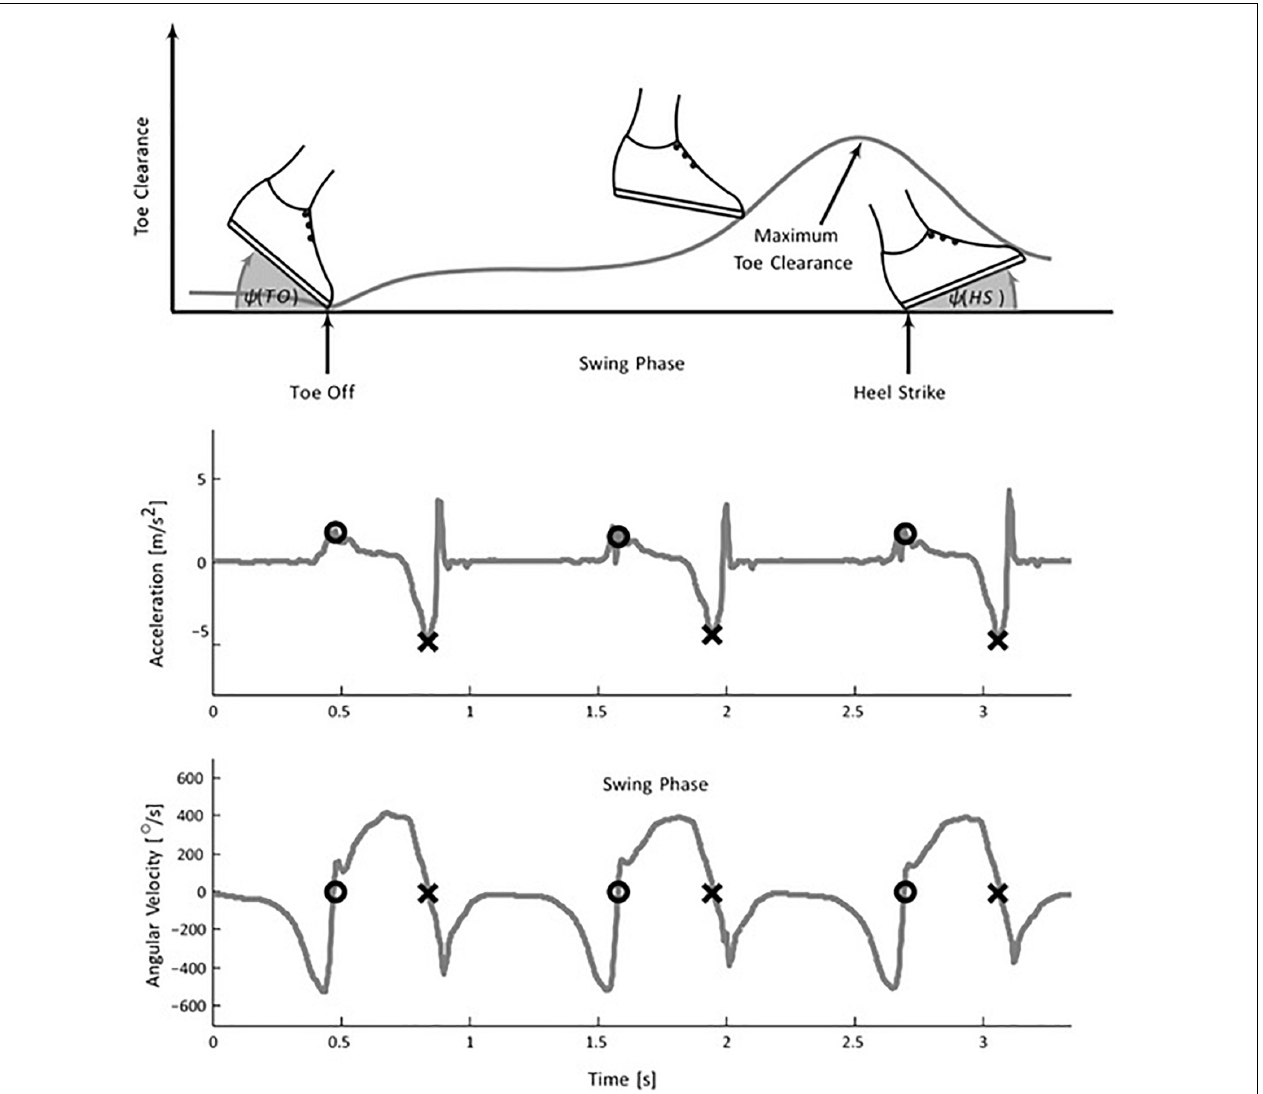
FIGURE 2 | Foot mounted inertial gait pattern in the sagittal plane. (Top) the plot shows a variation of foot angle (w.r.t. ground) at TO, HS, and toes clearance during the swing phase. The negative peak of the acceleration signal determines the HS (middle plot) whereas (lower plot) TO is extracted using the zero crossing of